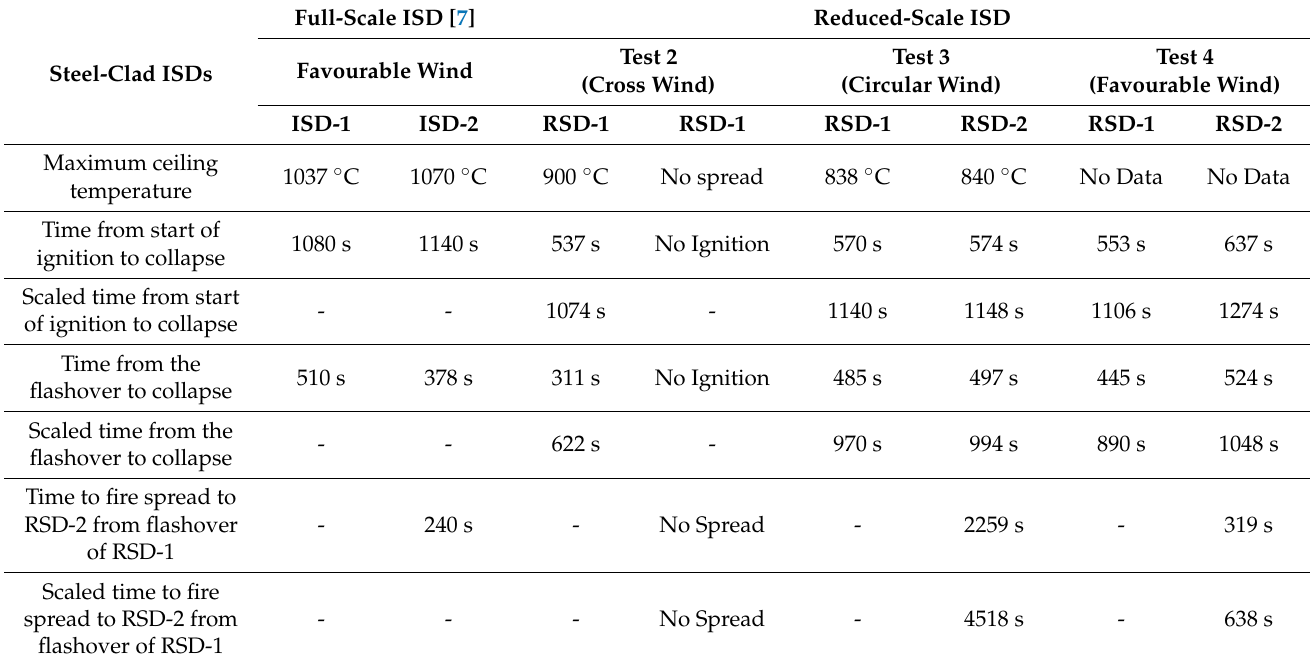
Table 5. Comparison on RSEs and FSEs results on fire spread between multiple steel-clad reduced scale